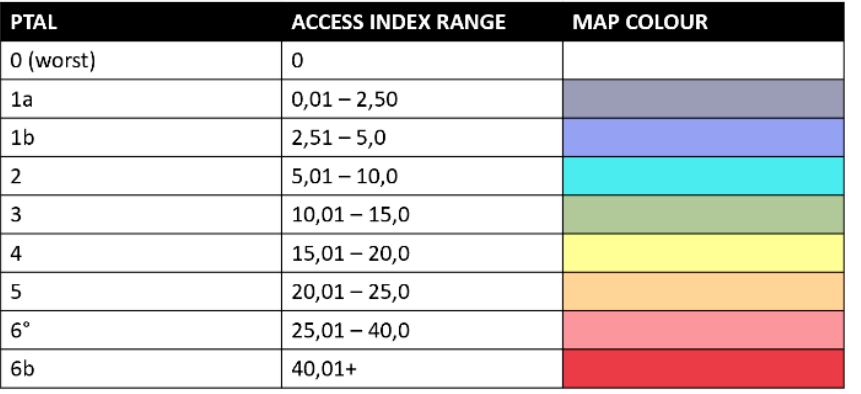
Figure 2. Conversion of the Access Index to PTAL and related color range (own elaboration adapted from [6]).